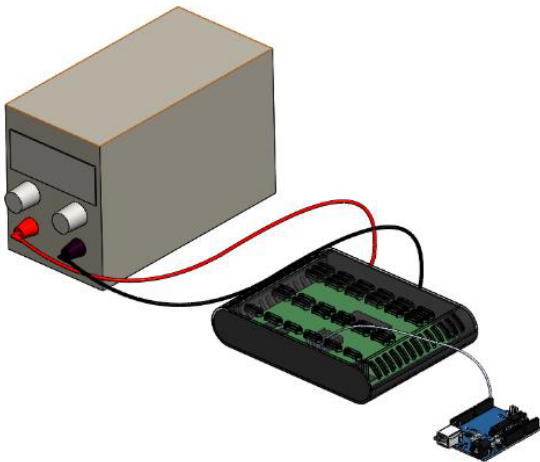
Figure 3. Three-dimensional drawing of the experiment.